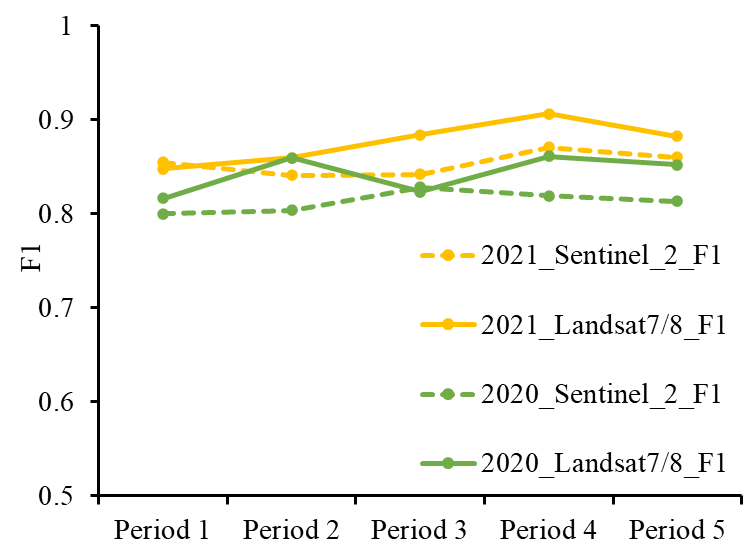
Figure 9. Comparison of accuracy between Sentinel-2 and Landsat 7/8 data.